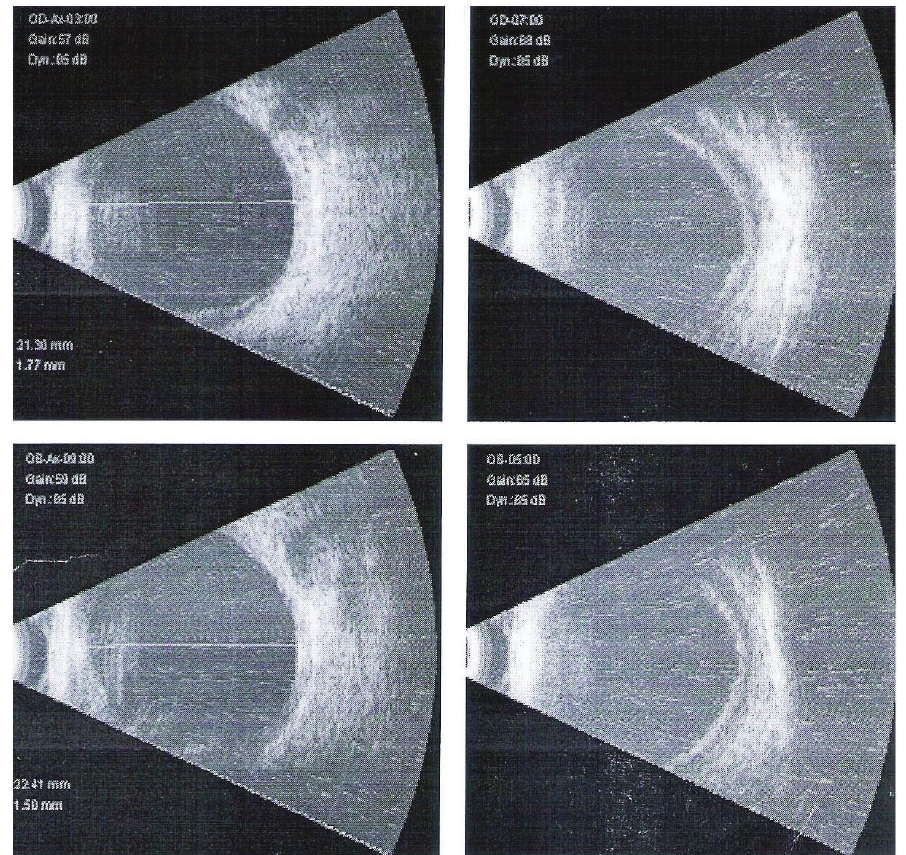
Figure 2: B-scan USG of patient in Case Report 1 with choroidal detachments on